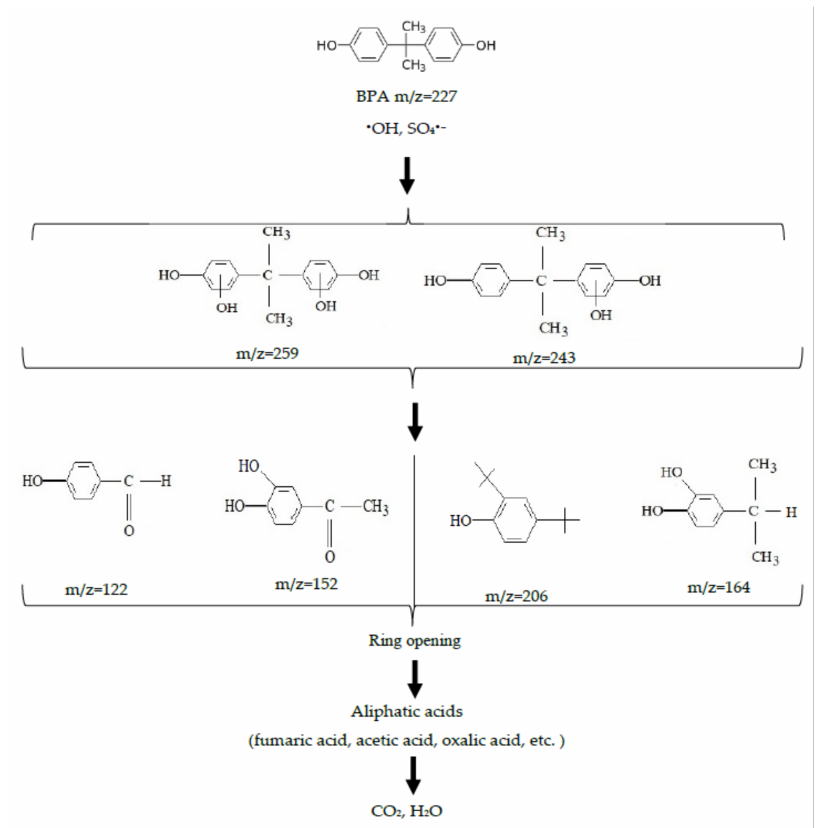
Figure 6. A proposed pathway of BPA oxidation in the UV/Fe 2+ /S 2 O 82 − system using a UV KrCl